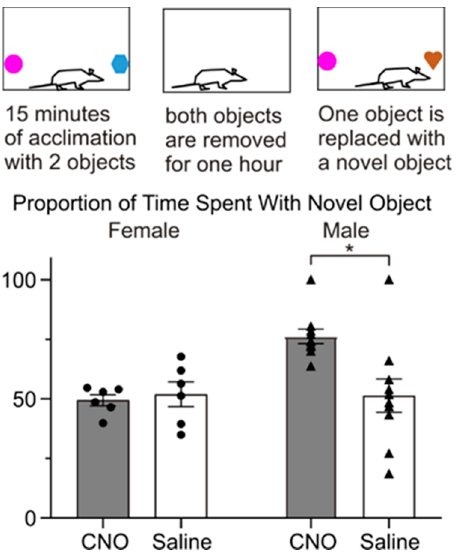
Figure 1. Male rats spent more time interacting with a novel subject than female rats. A graphic representation of the novel object paradigm is shown (top). Animals received an injection of Clozapine-N-Oxide (CNO) or saline 1 h prior to acclimation. Two randomly selected objects were placed within the cage and the animal was allowed to interact with both objects for 15 min. Both objects were removed for one hour, and then one of the former objects, along with one novel object was placed in the cage for 15 min. Histogram (bottom) shows the proportion of time interacting with a novel object (filled bars are with CNO treatment, open bars were with saline injection). While activation of DREADDs expressing PVN OXT neurons with CNO had no effect in females, activation of PVN OXT neurons significantly increased the proportion of time spent with the novel object in males. * p <